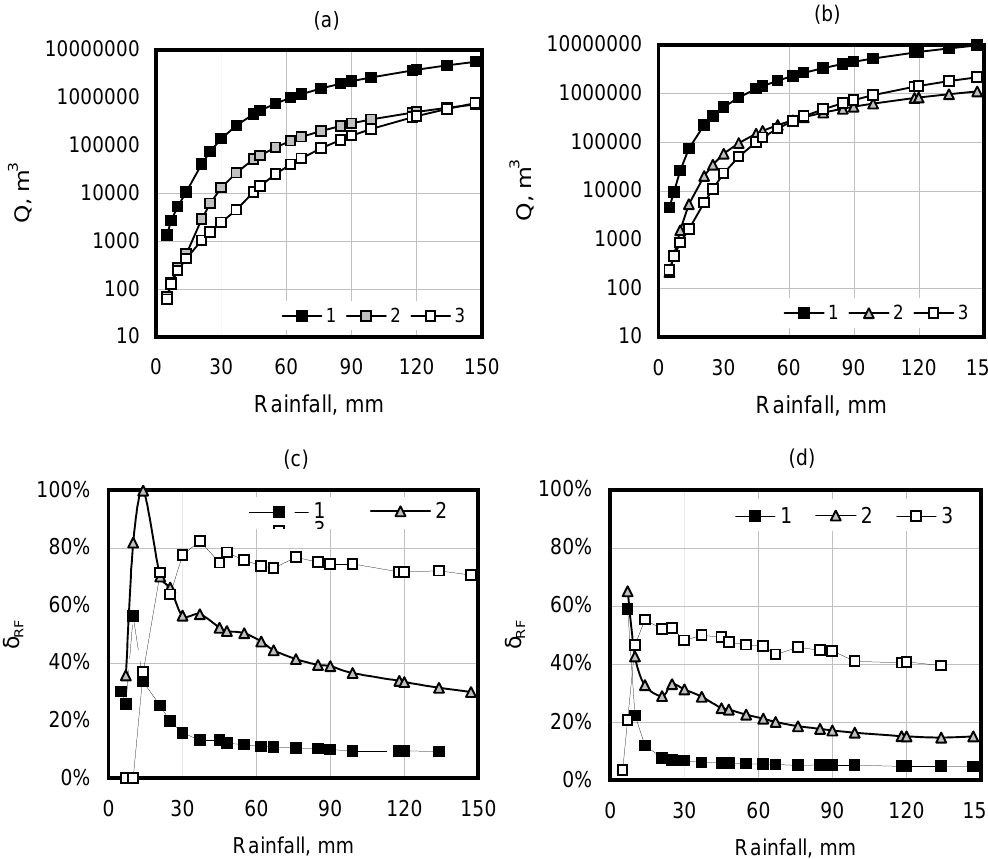
Fig. 10. Changes in catchment volumetric runoff Q (a, b) and the effect of the catchment contributing area δ (c, d) on these changes during the storage recovery stage (a, c) and storage deficiency stage (b, d) for the entire catchment (1), sub-catchment with clay soil (2) and sub-catchment with sandy soil (3).